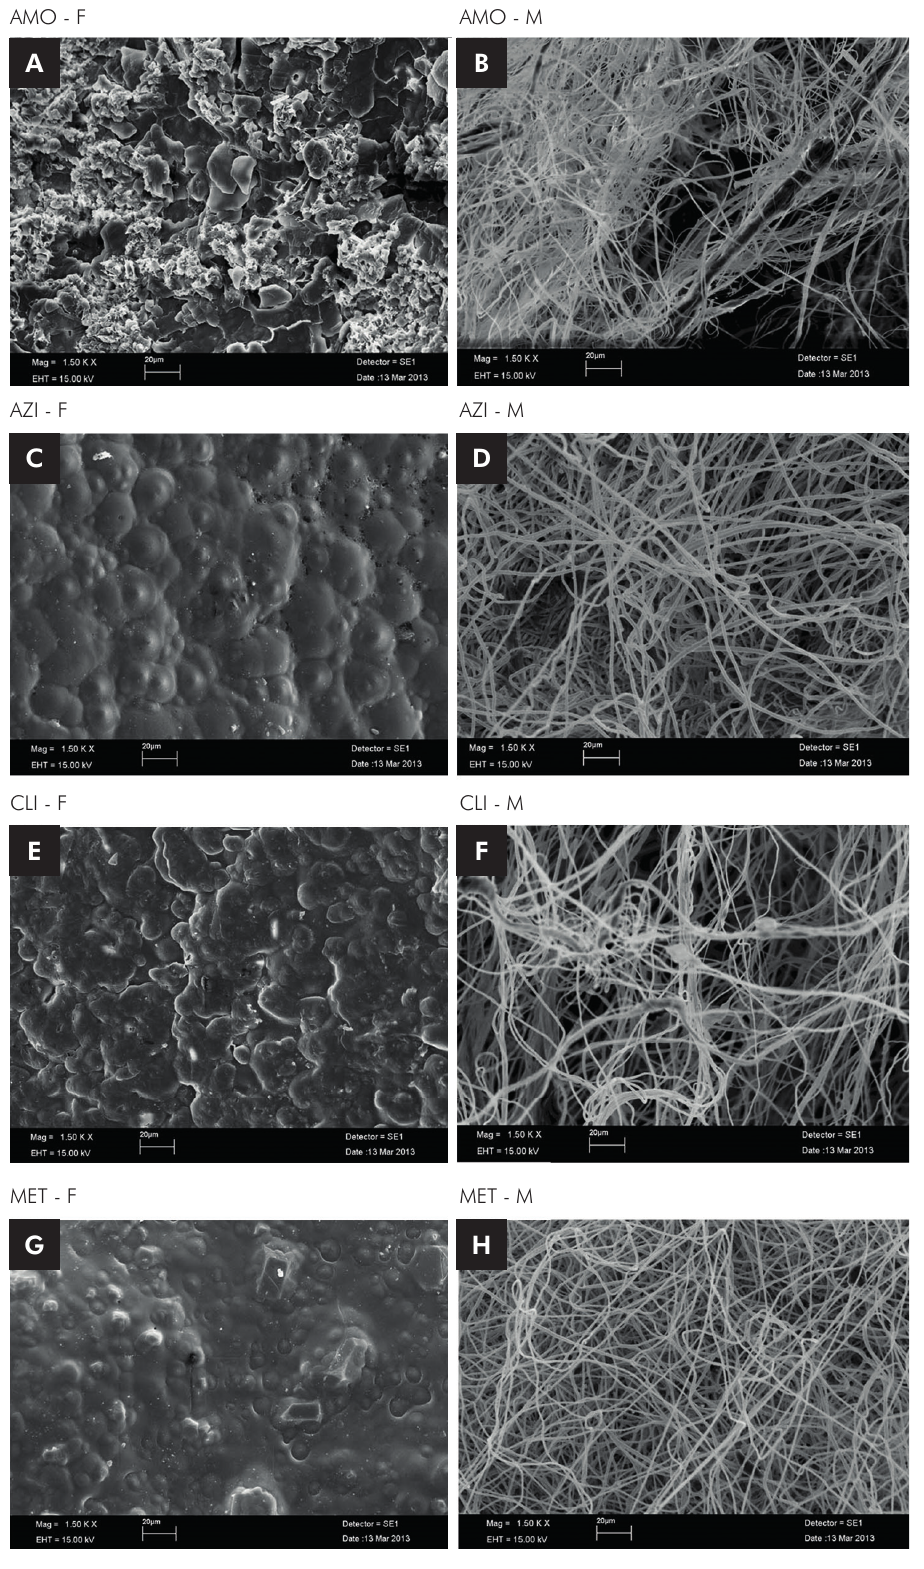
Figure 6. Film and Mesh SEM